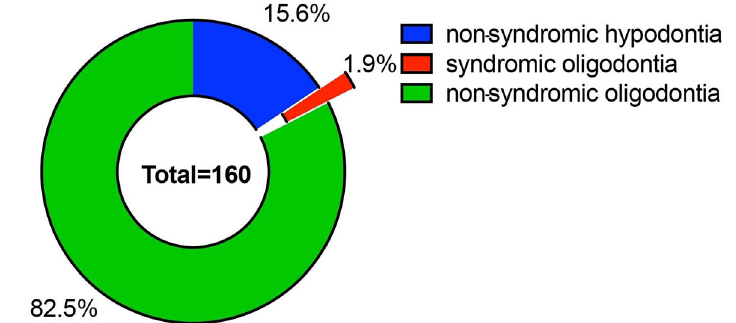
Figure 4- Phenotype composition of the 160 patients reviewed